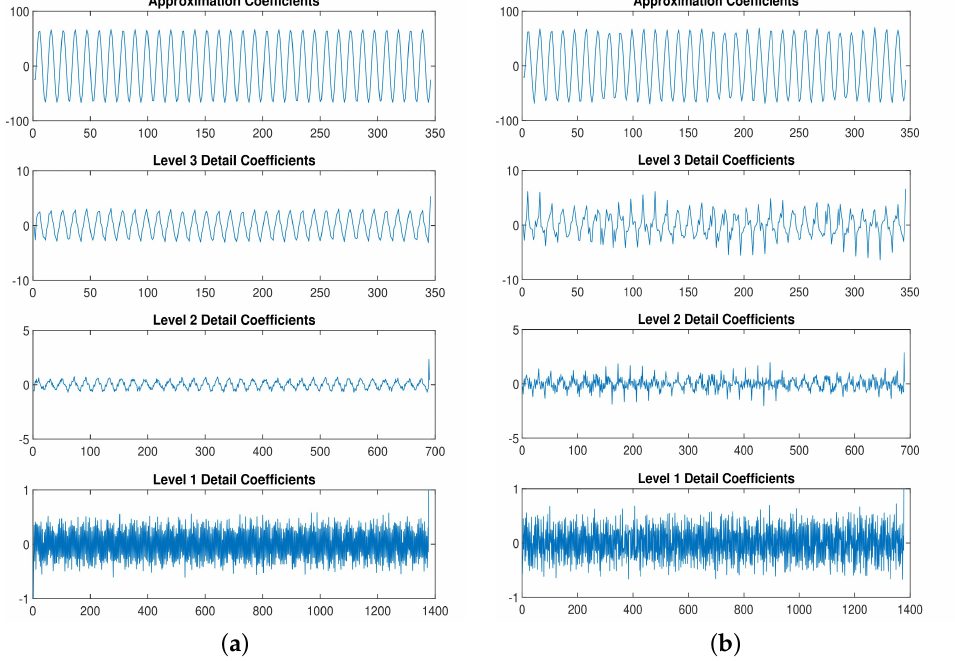
Figure 8. DWT coefficients for healthy and faulty current. ( a ) Healthy; ( b ) one broken